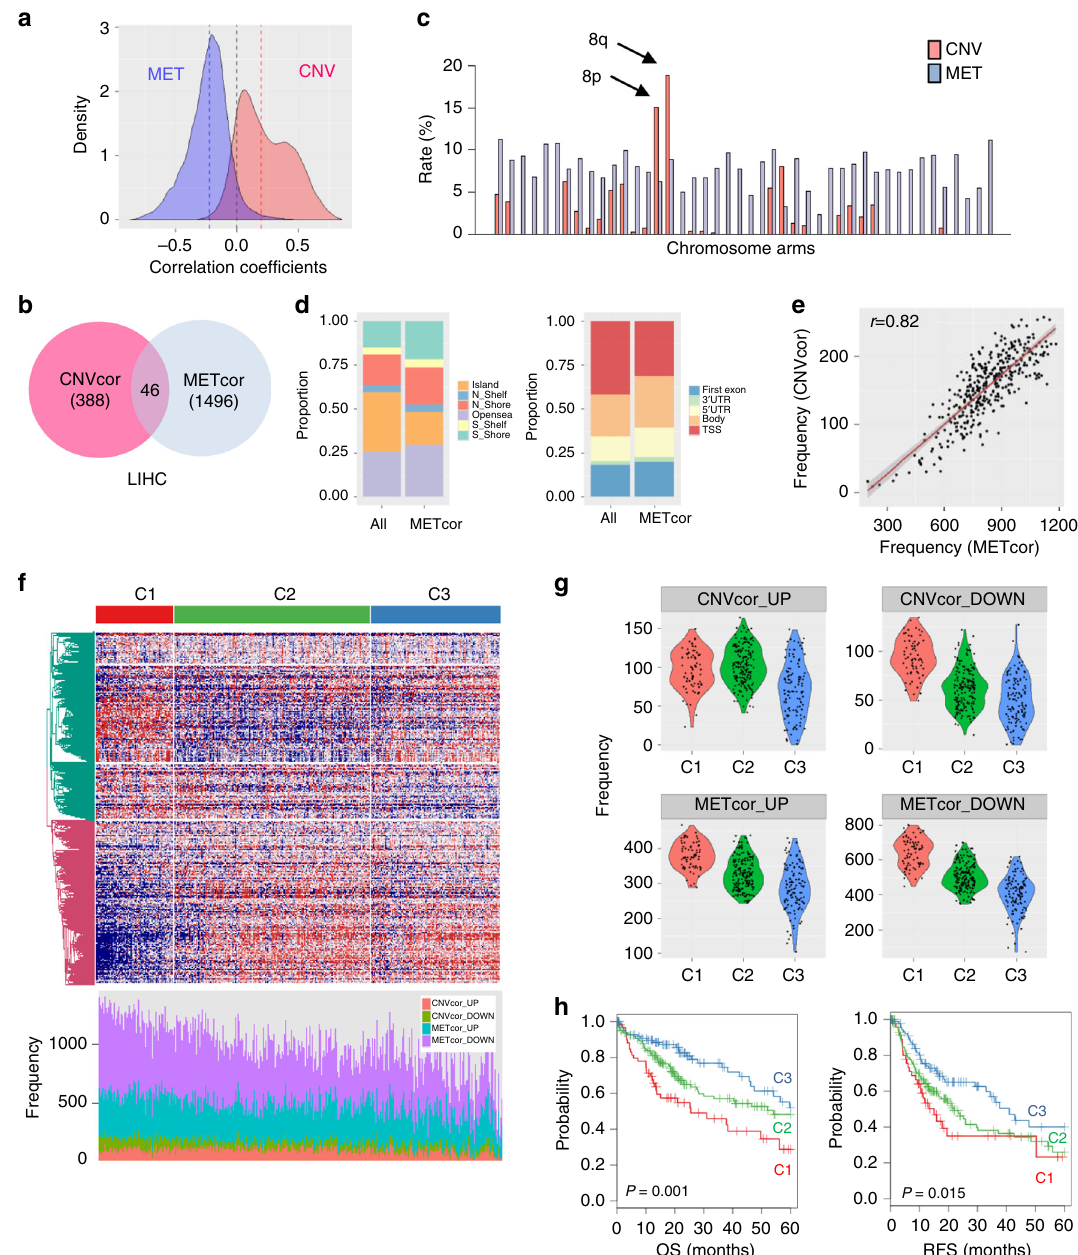
Fig. 3 Validation of molecular subtypes using an independent TCGA data. a Overall distributions of correlation coef fi cients of between the mRNA expression levels and DNA copy numbers or DNA methylation are shown, respectively. b A Venn diagram shows the counts of the DNA coy number- correlated genes (CNVcor) and the DNA methylation-correlated genes (METcor) genes. The counts of the overlapped genes between CNVcor and METcor are indicated. c Proportion of the CNVcor or METcor genes against total count of genes in each chromosome arm are shown. d Composition of DNA methylation probes in the whole genes and METcor genes are compared. Genomic positions of DNA methylation probes are categorized based on the relations with CpG island regions (right) and gene regions (left), respectively. e A plot shows the correlation between the frequencies of CNVcor and METcor genes in each sample. f A heatmap shows the expression patterns of the differentially expressed genes among the subtypes identi fi ed by iClusterPlus analysis (top). The frequencies of CNVcor_UP, CNVcor_DOWN, METcor_UP, and METcor_DOWN genes are shown (bottom). g Violin plots indicate the frequencies of CNVcor_UP, CNVcor_DOWN, METcor_UP, and METcor_DOWN genes are shown in each subtype of C1, C2, and C3, respectively. h Kaplan – Meier plot analyses of the HCC subtypes for overall survival (OS) and recurrence-free survival (RFS) are shown,